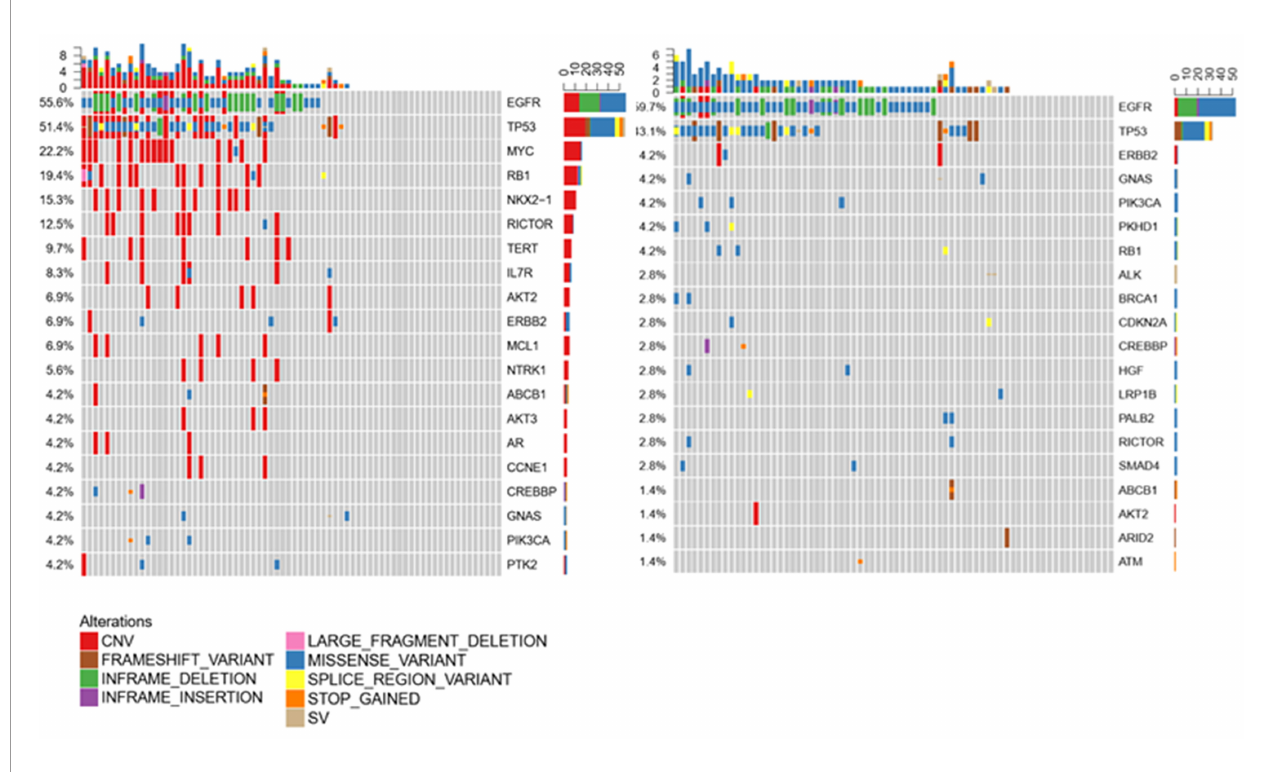
FIGURE 4 | Molecular features in 72 samples were compared in CSF and